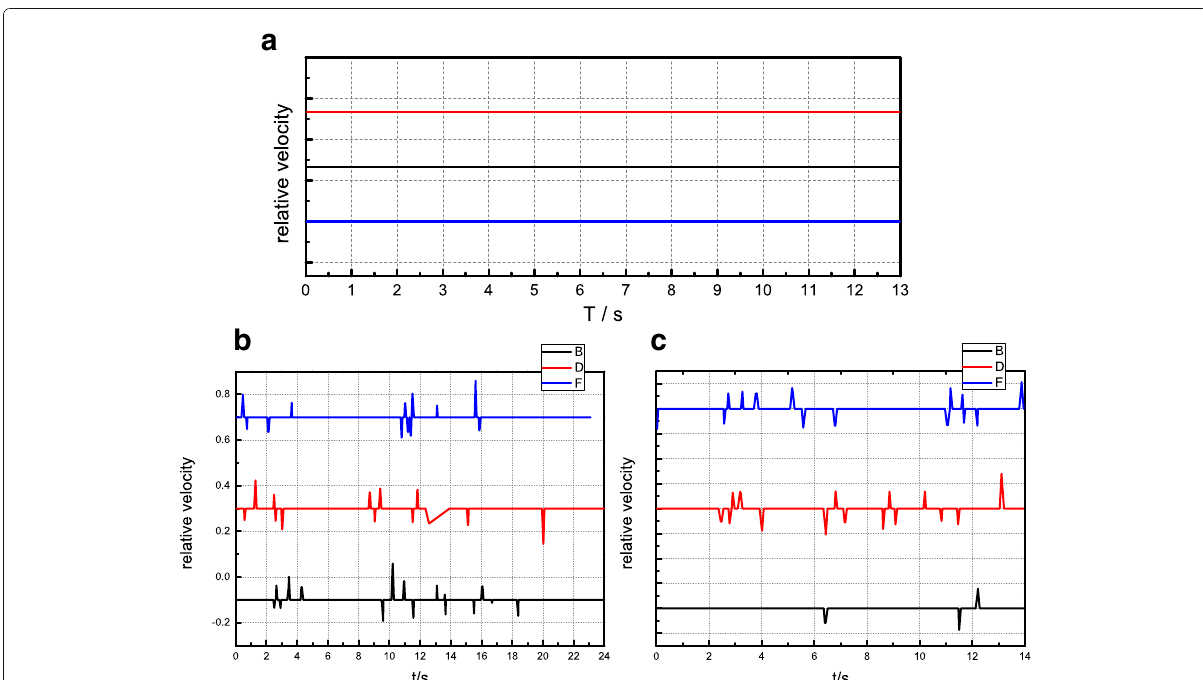
Fig. 2 a The relative speed of the tags, when no one in the supermarket. b The relative speed of the adjacent tags that are fully covered or half blocked by volunteers, when volunteers come from nearby tags. c The relative speed of the non-adjacent tags, when customers come from the vicinity of the tags